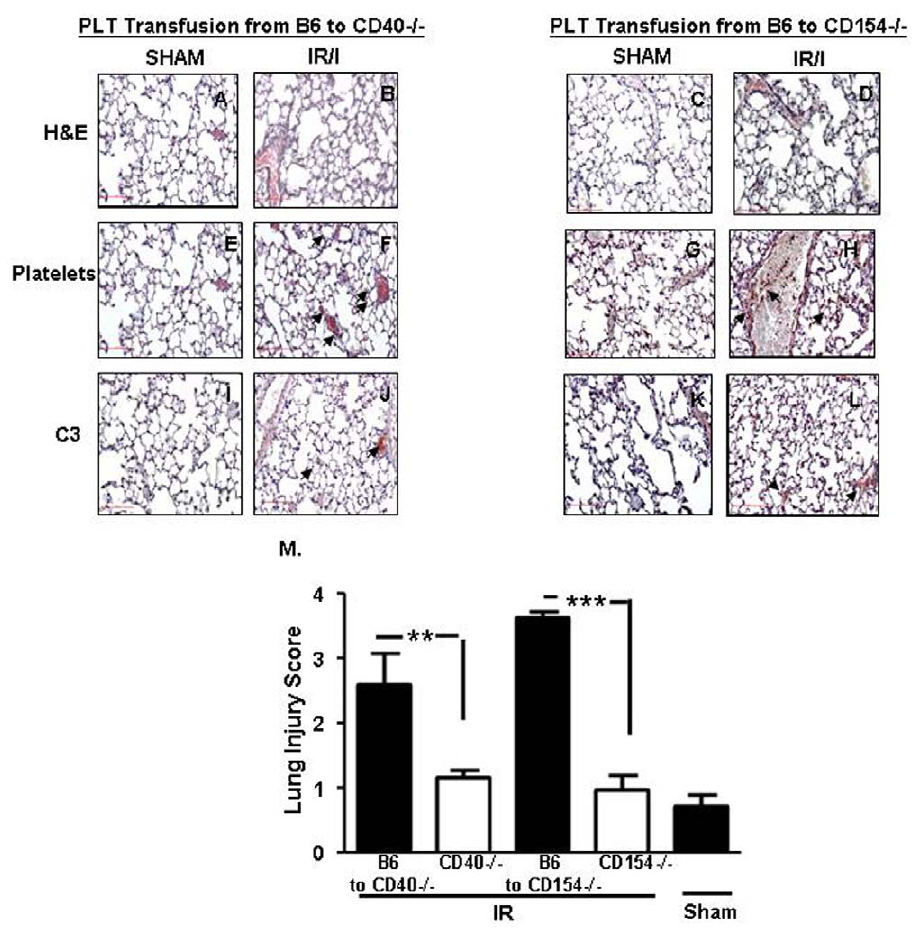
Figure 5. Remote lung injury is re-established in CD154 2 / 2 and CD40 2 / 2 mice transfused with B6 platelets. (A–D) Hematoxylin and eosin, (E–H) platelets and (I–L) C3 complement factor stained sections of mouse lung from CD154 2 / 2 and CD40 2 / 2 mice transfused with B6 platelets after 30 minutes of ischemia and 3 hours reperfusion. Images are representative of 3–4 mice per group in two experiments. All images shown are 200 6 magnification. (M)Injury score (mean 6 SD) in intestine and lung. ns: not significant *p # 0.05, **p # 0.01, and ***p # 0.001 for I/R compared to sham controls. Small arrows: indicate areas of positive staining.